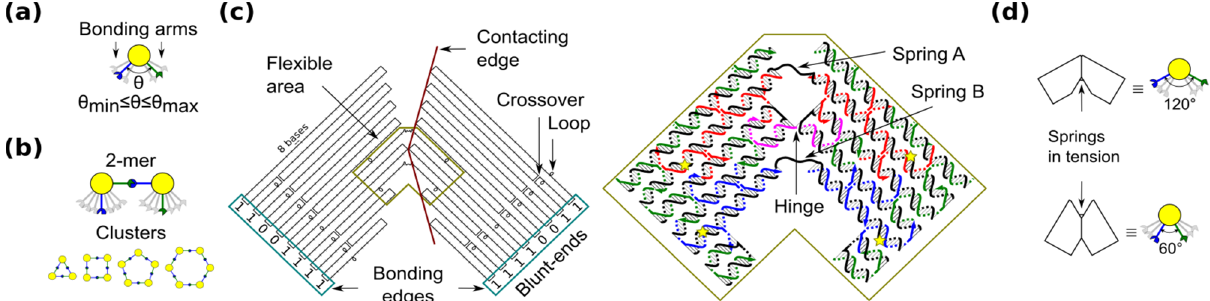
Figure 1. Shape-variable building block and design with DNA origami. ( a ) Abstract representation of the block with two bonding arms; ( b ) 2-mers in cis configuration and assembled polymorphic clusters (from 3-mers up to 6-mers); ( c ) ( left ): Origami scaffold (black), flexible area (mustard), contacting edges (red) and blunt-ends with binary codes (sky-blue); ( right ): Detail of the flexible area showing staples in colour (yellow stars indicate scaffold loops for tuning springs); ( d ) Origami profile and its correspondent abstract representation for the 60° and 120°